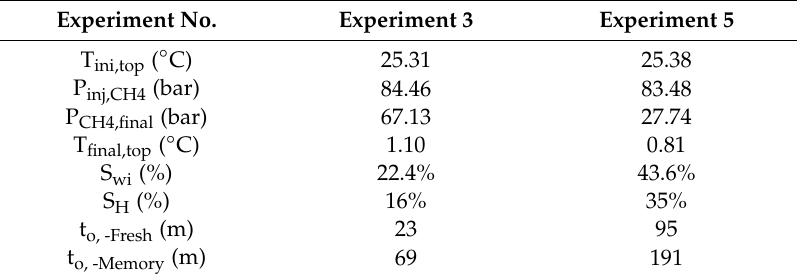
Table 3. Methane hydrate formation in the presence of 500 ppm